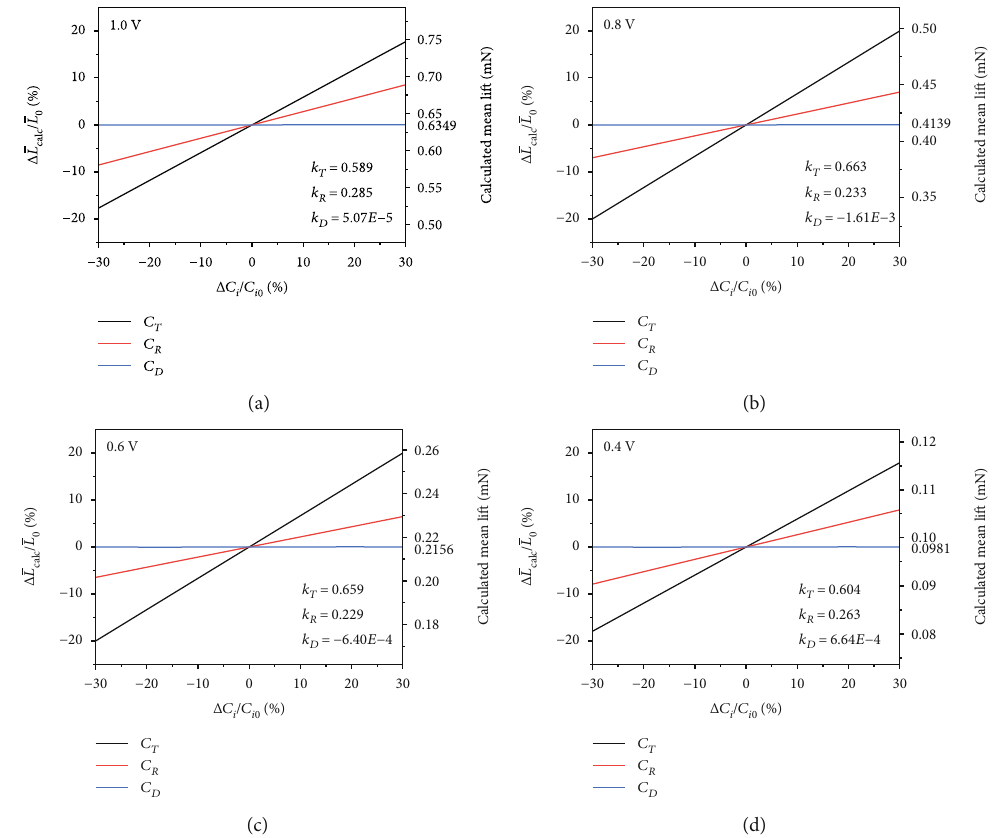
Figure 10: Analysis of the sensitivity of the calculated mean lift of the robot to the aerodynamic constants of C voltage amplitudes of (a) 1.0V, (b) 0.8V, (c) 0.6V, and (d) 0.4V (the number of input values is limited for simplicity).